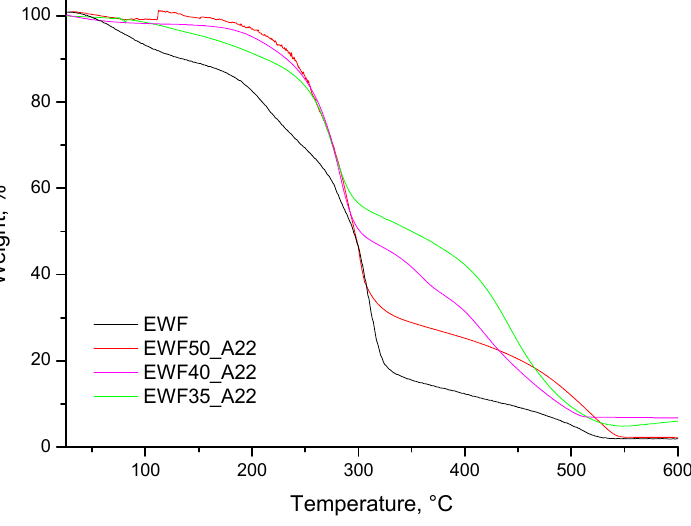
Figure 9. TGA on EWF with different Polar resin contents .